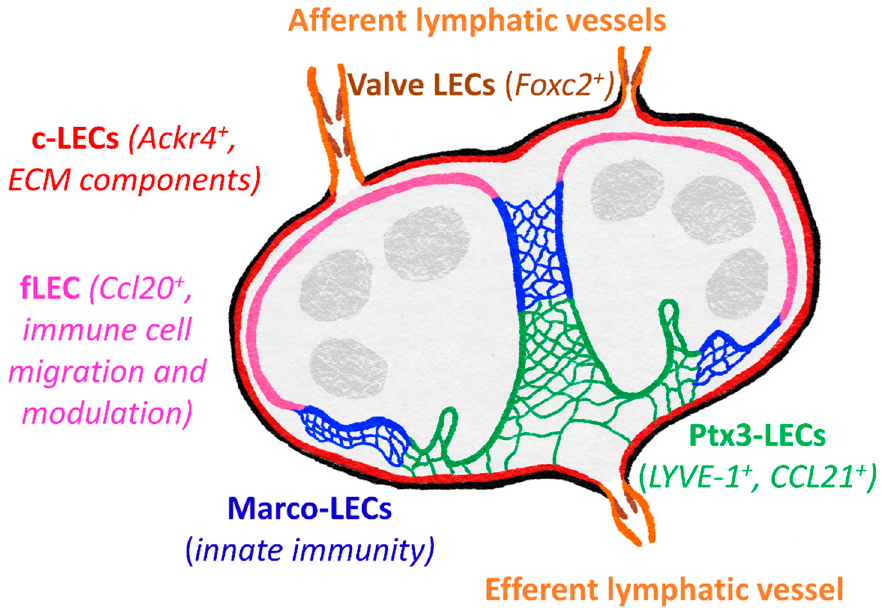
Figure 3. Subsets of lymphatic vasculature within the lymph node. Specialized gene expression profiles revealed five major distinct LEC subsets in both mouse and human lymph nodes [136]. These include valve cells of the afferent and efferent lymphatic vessels, SCS ceiling LECs (c-LECs) and floor LECs (f-LECs), and medullary sinus Marco-LECs and Ptx3-LECs. Genes of the c-LECs and Ptx3-LECs suggest roles in maintaining the structure of the lymph node, whereas f-LEC appear specialized for regulating lymph-borne immune cell entry and antigen presentation, with Marco-LECs important in innate immunity and response to pathogens. Ptx3-LECs also express numerous genes to suggest responsiveness to inflammation-induced remodeling and expansion of medullary and paracortical sinuses.